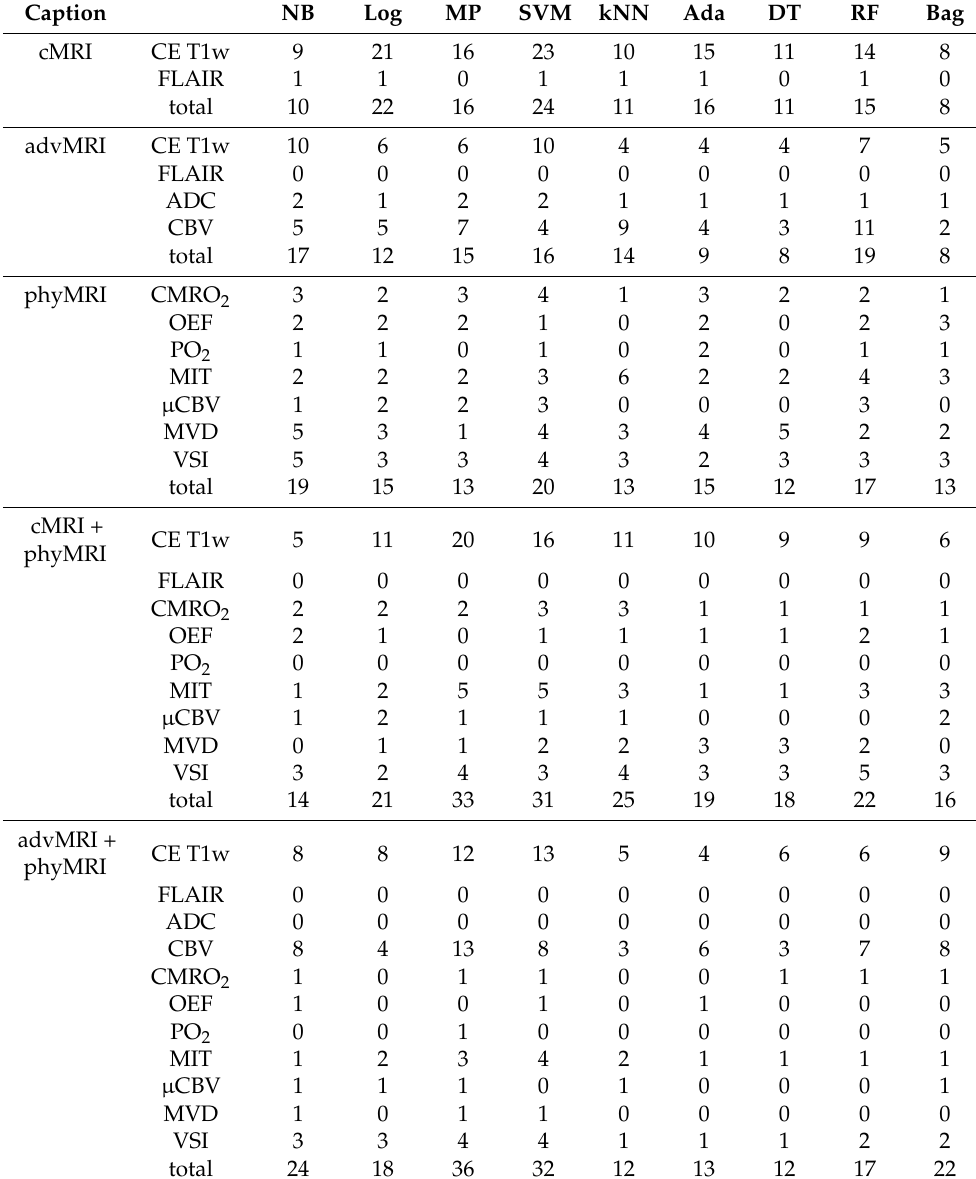
Table 2. Number of the selected radiomic features for the ML algorithms and the MRI data